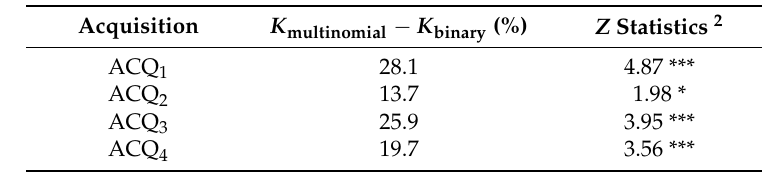
Table 7. Test of differences between overall Kappas ( K ) derived from classification of trees and non-tree objects in cross validation of logistic regression models based on multinomial 1 and binary responses,